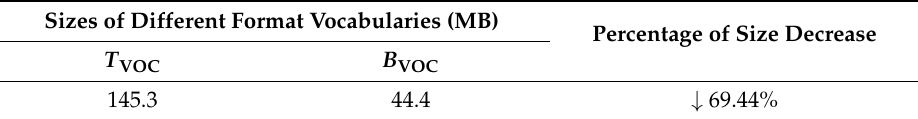
Table 1. Then, we used two kinds of vocabulary to start the system five times each. Time cost statistics are shown in Table 2. Table 1. The size comparison between text vocabulary and binary vocabulary.